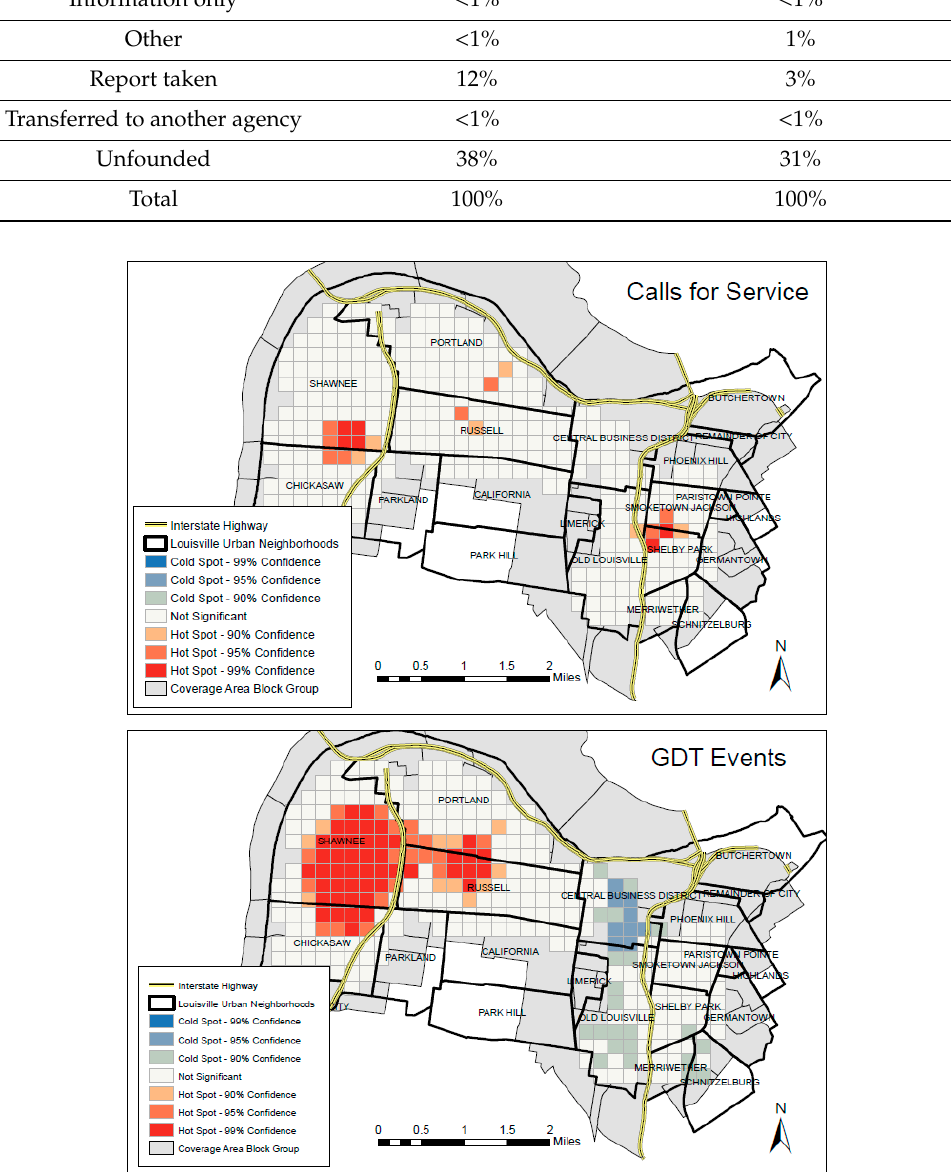
Figure 4. Hotspot analysis of calls for service vs. GDT events in Louisville, KY.